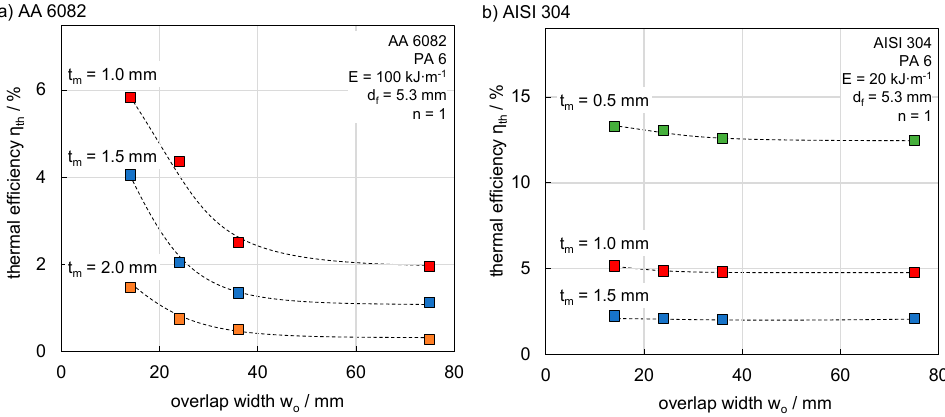
Figure 9. ( a ) The dependence of thermal efficiency on overlap width with constant energy per unit length for AA 6082 and ( b ) AISI 304.